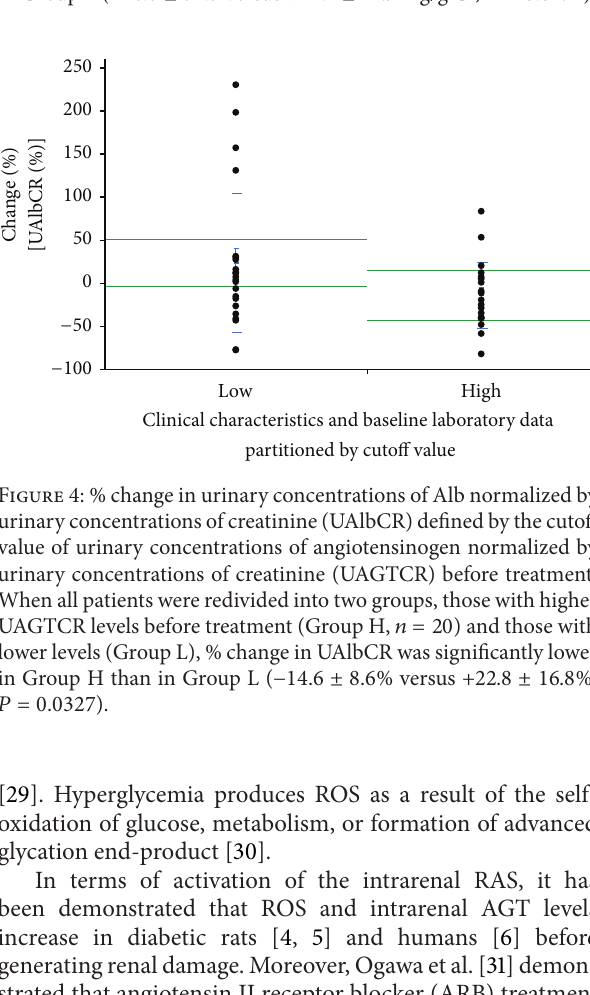
[29]. Hyperglycemia produces ROS as a result of the